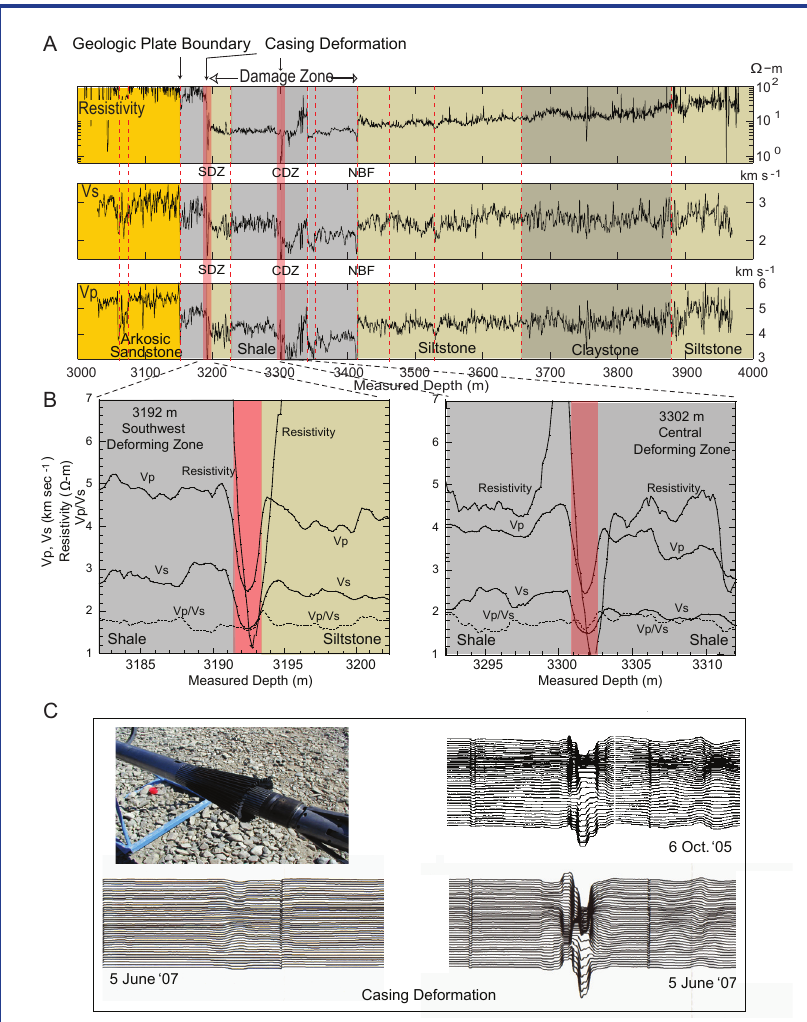
Figure 4. [A] Selected geophysical logs and generalized geology as a function of measured depth along the Phase 2 SAFOD borehole. The dashed red lines indicate some of the many faults encountered. The thick red lines indicate where fault creep deformed the Phase 2 cased borehole at the SDZ and CDZ. Depth in this figure represents the measured depth along the length of the wellbore. [B] The SDZ and CDZ correlate with localized zones (shown in red) where the geophysical log properties from Phase 2 are even more anomalous than in the surrounding damage zone. The same is true of the fault at the northeast boundary of the damage zone, the NBF. [C] After the borehole was cased and cemented, a 40-finger caliper (see photo) was used to measure the casing radius at various times (the depth scales are the same as in [B]). The caliper data obtained on 6 October 2005 showed significant casing deformation within the CDZ. When the casing was resurveyed on 5 June 2007, more deformation was observed at the depth of the CDZ, and slight deformation was observed at the SDZ. Although the NBF is geophysically quite similar to the SDZ and CDZ (see [A]) and is associated with the SF and LA earthquake sequences (Figs. 2 and 3), no casing deformation was identified at that